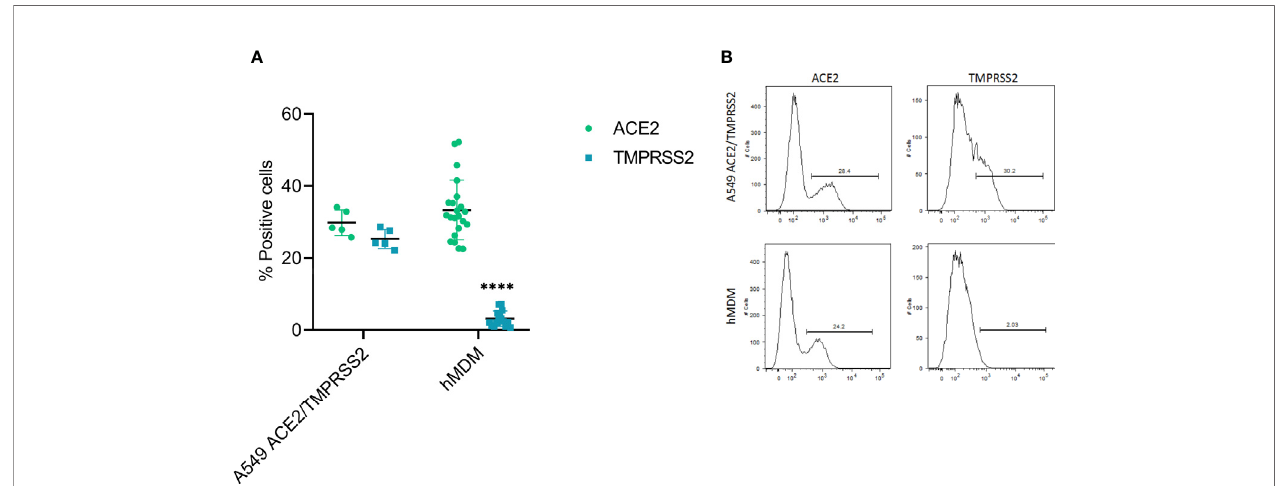
FIGURE 4 | ACE2 and TMPRSS2 expression in hMDM. After 6 days of differentiation ACE2 and TMPRSS2 were immunolabeled with speci fi c antibodies and positive cells were assessed by fl ow cytometry. A549 cells transfected with ACE2 and TMPRSS2 were used as control (A) . Representative histograms for each marker in the analyzed cells are shown (B) . The data from 5 different human donor hMDM run in triplicates are shown. Statistically signi fi cant differences in the expression of each marker between both cell types are marked by asterisks (****p ≤ 0.0001).